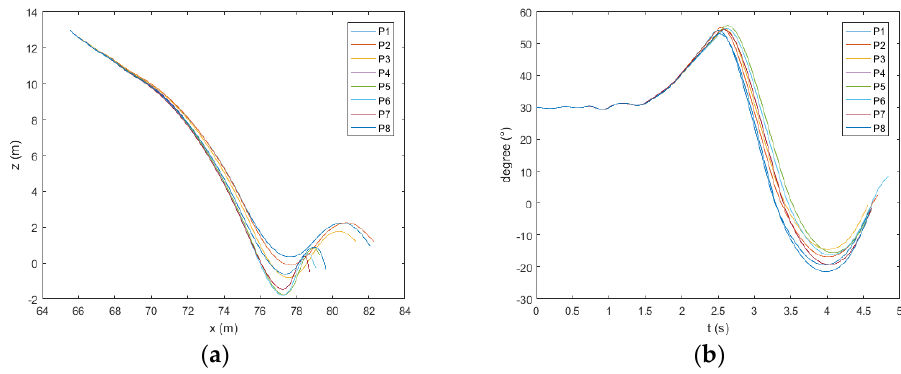
Figure 14. Trajectory ( a ) and pitch ( b ) of the lifeboat freefall when the wave height is 2 m.